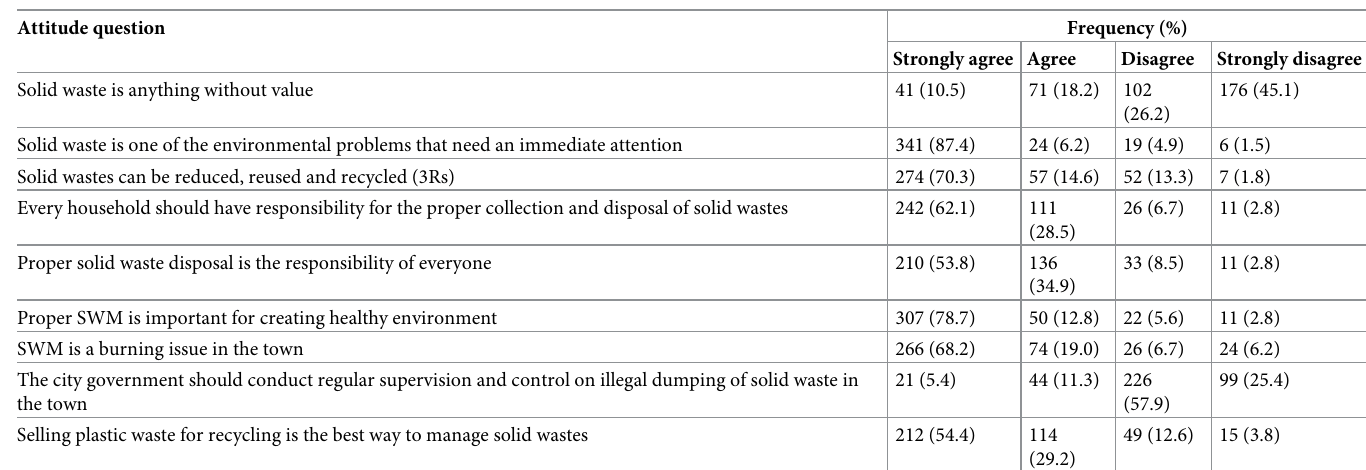
Table 3. Households‘attitudes towards